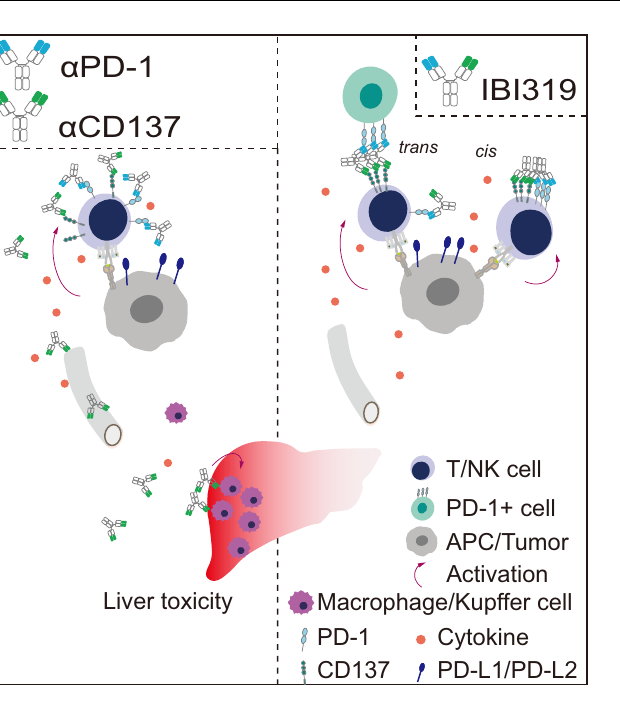
Fig. 5 Working model of IBI319. IBI319 activates CD137 in a manner restricted to PD-1-rich microenvironments, such as tumours and tumour- draining lymph nodes, limiting potential liver toxicity caused by the α CD137 and α PD-1